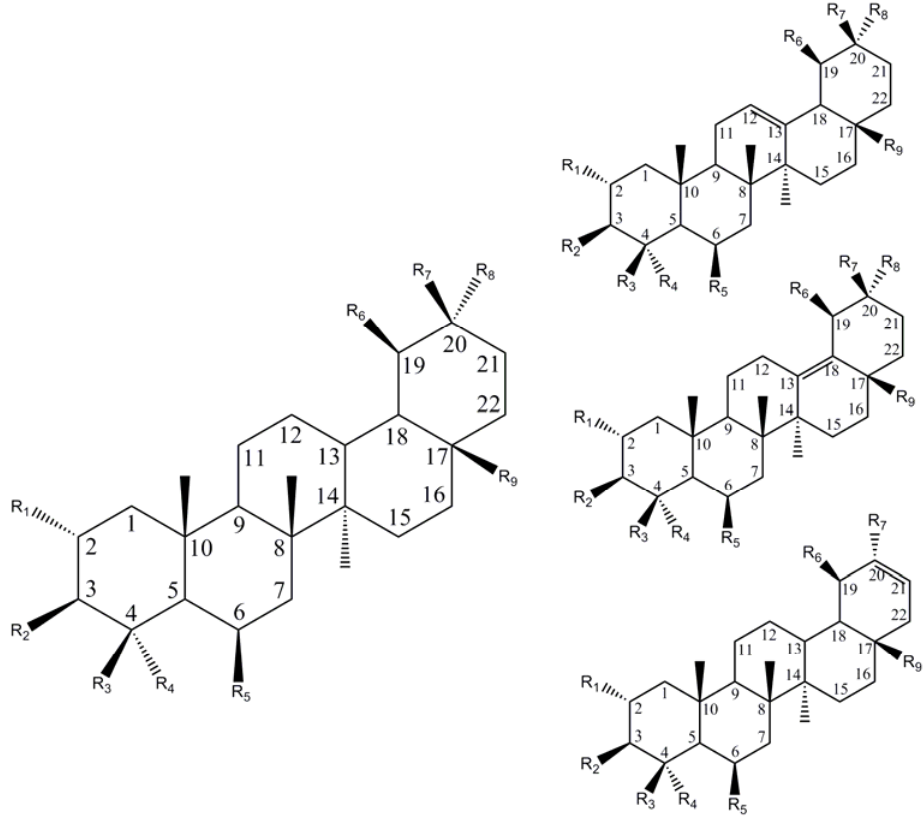
, R = methyl) or oleanane (R 6 7 -C , C -C or C -C 12 13 13 18 20